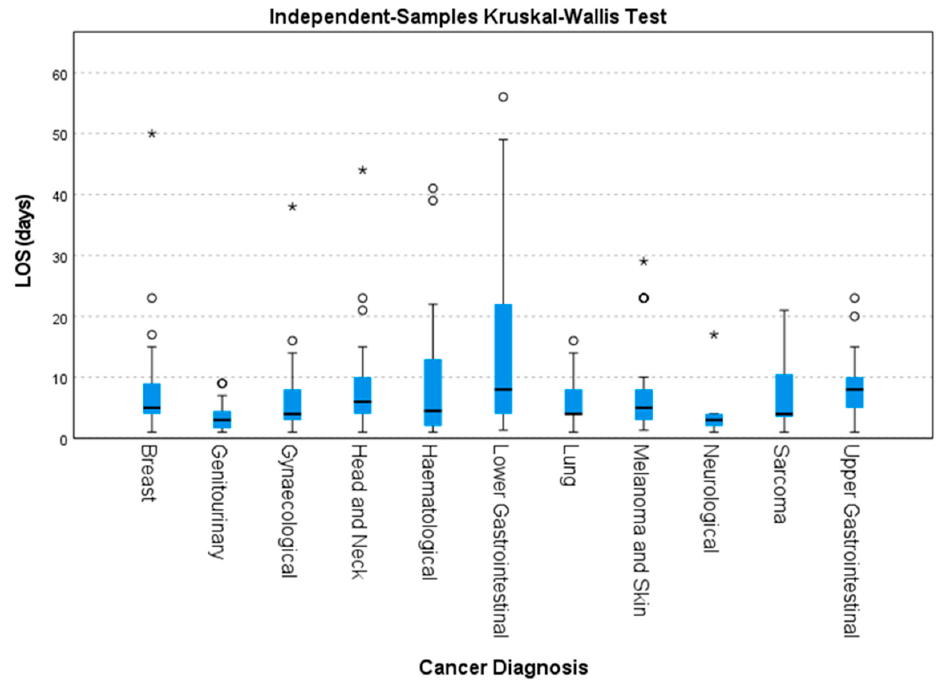
Figure 2. Box and whisker plot showing variability of LOS by cancer diagnosis using Kruskal–Wallis tests of independent samples. Small circles (o) represent outliers defined as >1.5 times the IQR larger than the third quartile. Stars represent high extreme values >3 IQR above quartile 3.